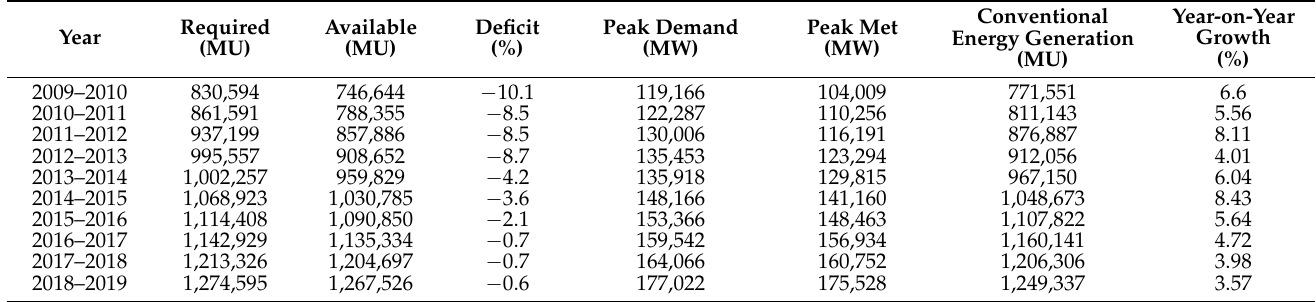
Table 1. Energy scenario in India, 2010–2019